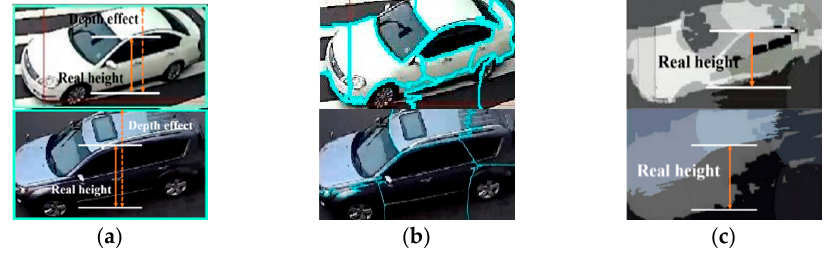
Figure 11. Segmentation of the vehicle class. ( a ) Object depth effect; ( b ) Super-pixel segments; ( c ) Superimposition.